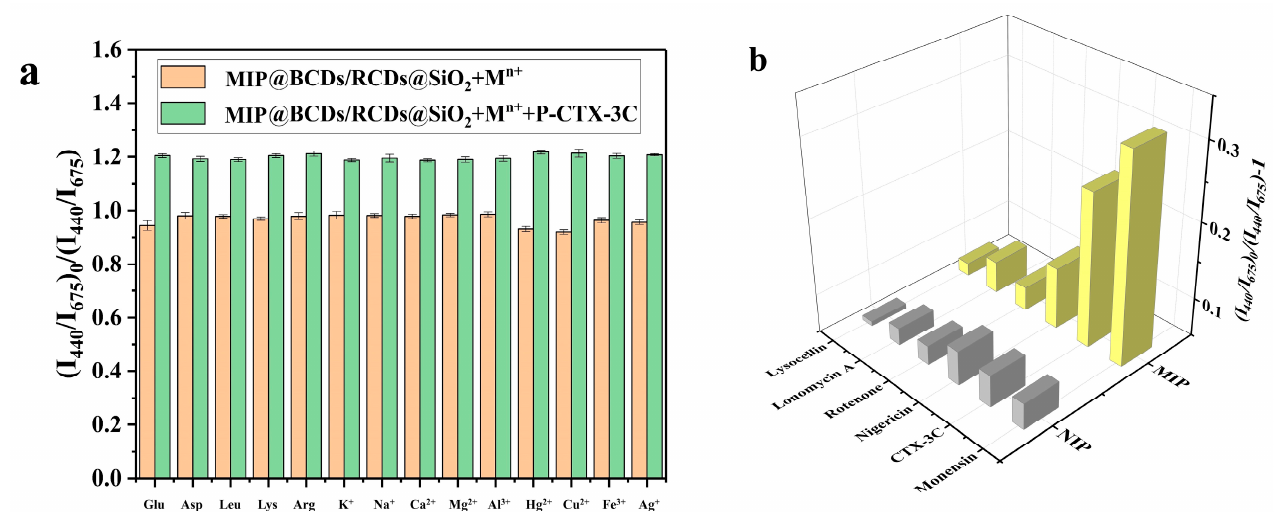
Figure 4. ( a ) Interference effects of various amino acids and metal ions; ( b ) selectivity diagram